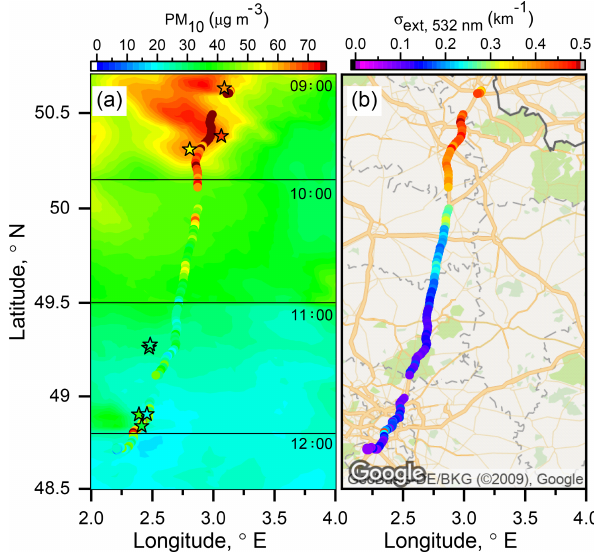
Figure 12. Spatial variability of (a) modelled PM 10 concentra- tions and PM 10 measured by mini-WRAS during mobile observa- tions along Lille–Palaiseau transect on 28 August 2017. Air qual- ity stations along the road are marked with colour mapped stars. The colour map is the same for both the measured and the mod- elled PM 10 concentrations. (b) Extinction coefficient at 532nm at ground level computed using Mie calculations on aerosol spectrom- eter